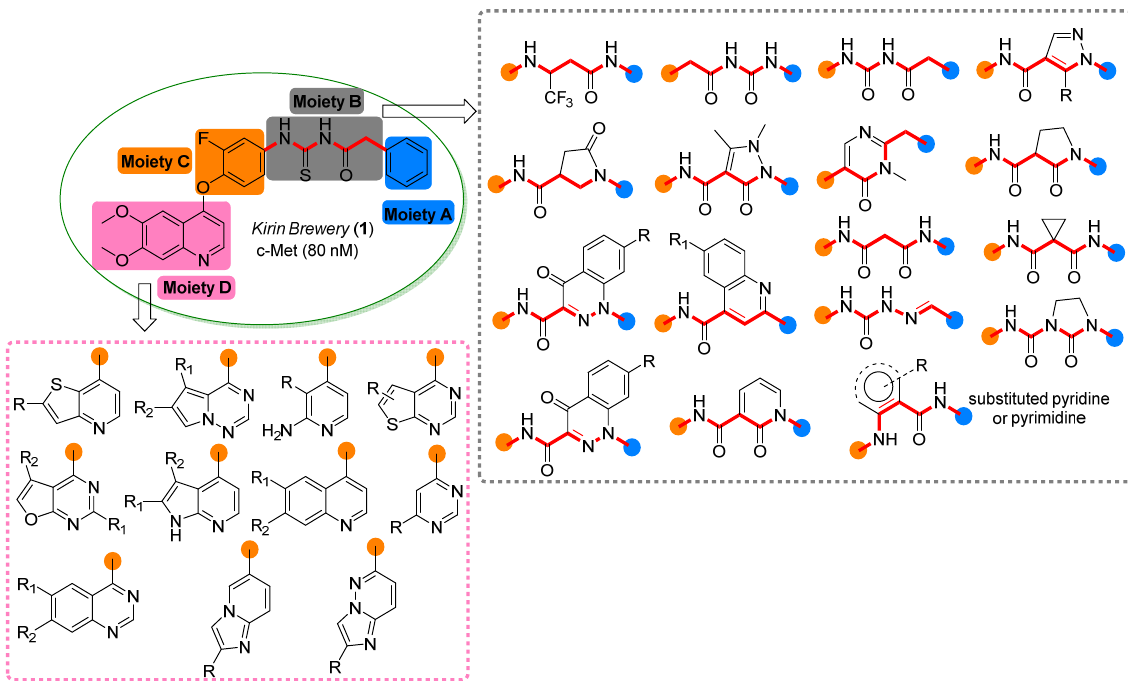
Figure 1. Representative scaffolds used for the structural optimization of c-Met